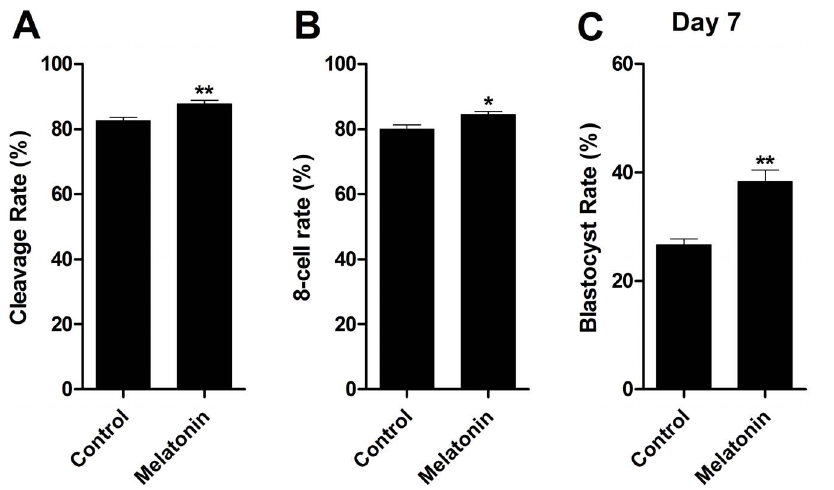
Figure 1. Effects of melatonin on the developments of invitro maturation/fertilization bovine embryos. A: cleavage rate; B: 8-cell rate; C: blastocyst rate at Day 7 ( in vitro fertilization=Day 0). Different superscripts in each column present statistical significant differences (P , 0.05).